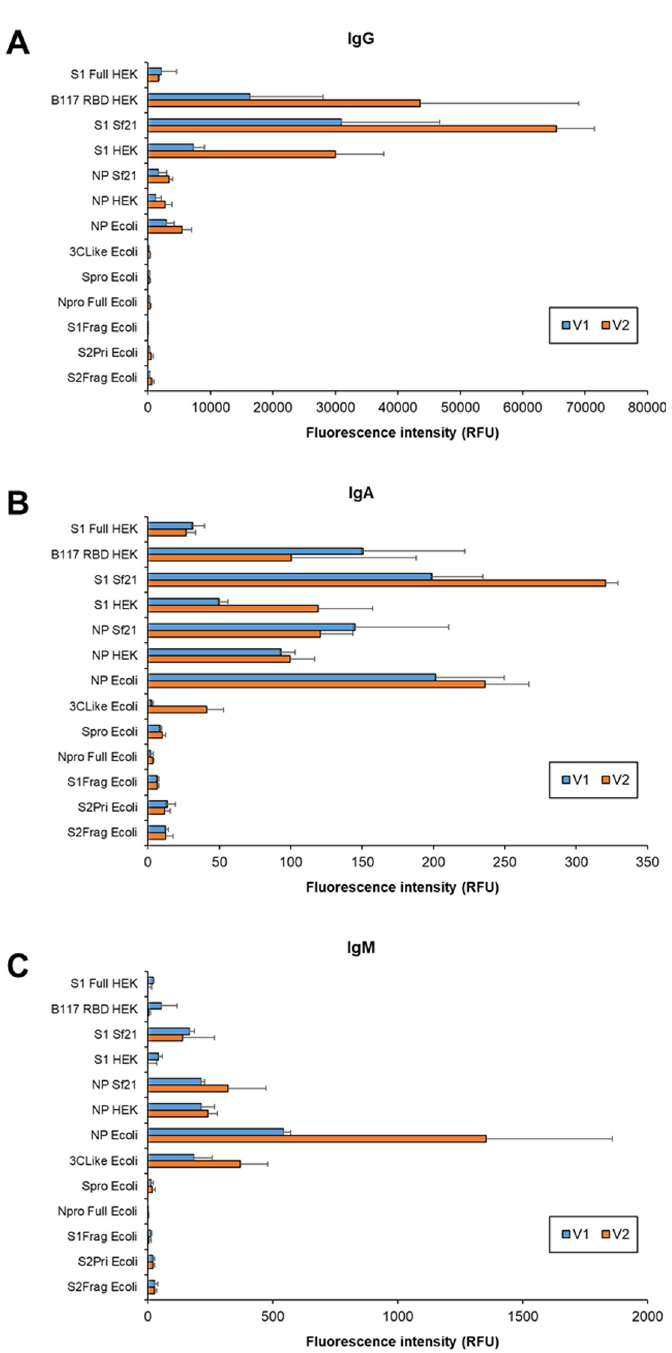
Fig 9. Serum antibody response of double vaccinated healthy donors with no previous SARS-CoV-2 infection. Bar charts represent binding intensity of purified serum (A) IgG, (B) IgA, and (C) IgM from two double vaccinated healthy donors V1 (M, 60 years old) and V2 (F, 34 years old) with no previous SARS-CoV-2 infection (V1 and V2) to immobilised antigen detected by fluorescently-labelled anti-isotype antibodies. Bars represent the average binding intensity from three replicate experiments with error bars of +/- 1